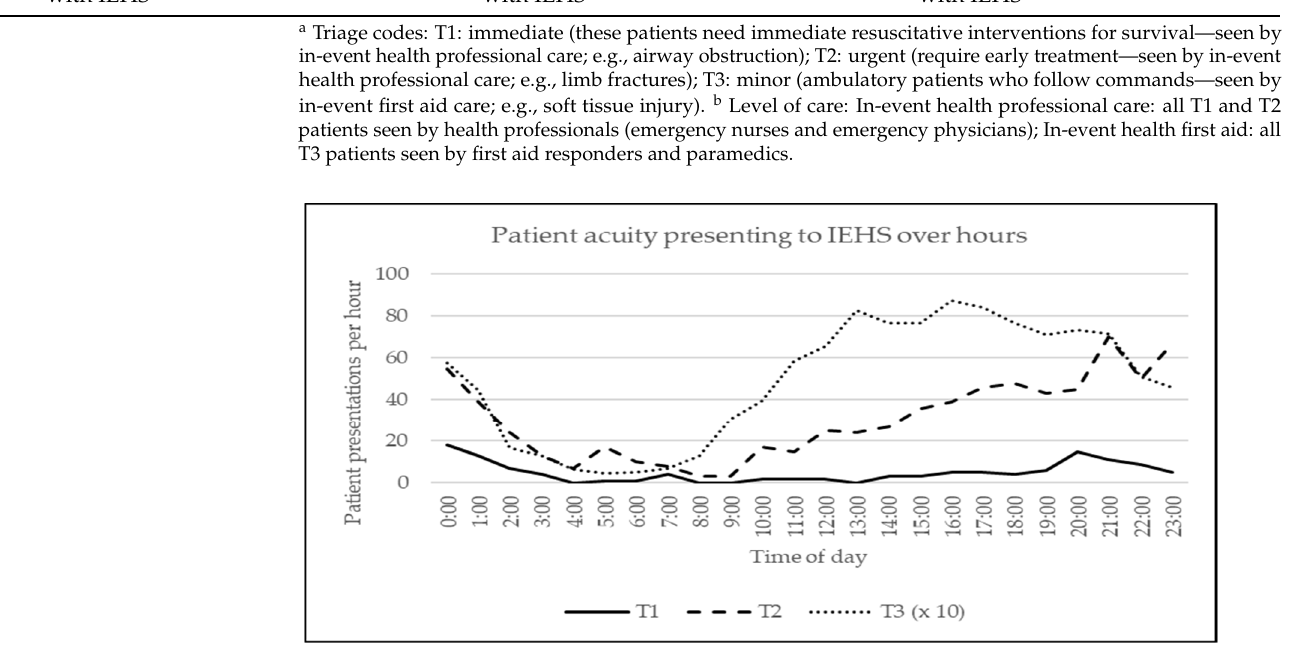
Figure 3. Patient acuity presenting to IEHS over hours (the number of T3 patients was divided by 10). Of the 851 T1 or T2 patients, 745 (87.54% [95% CI 87.32 to 87.76]) returned to the festival after receiving care. However, IEHS transported 106 (12.46% [95% CI 12.10 to 12.82]) T1 or T2 patients to nearby hospitals, of which the majority ( n = 19; 18.3% [95% CI 17.7 to 18.9]) needed transport because of substance and/or alcohol intoxication. Nine (1.1% [0.5 to 1.8]) other patients who received care from in-event health professionals went to the hospital by their own means. We found a significant association ( χ 2 (1) = 956.2, p < 0.0001)